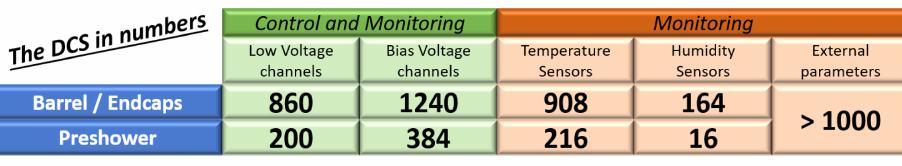
Figure 1. The CMS ECAL DCS in numbers.